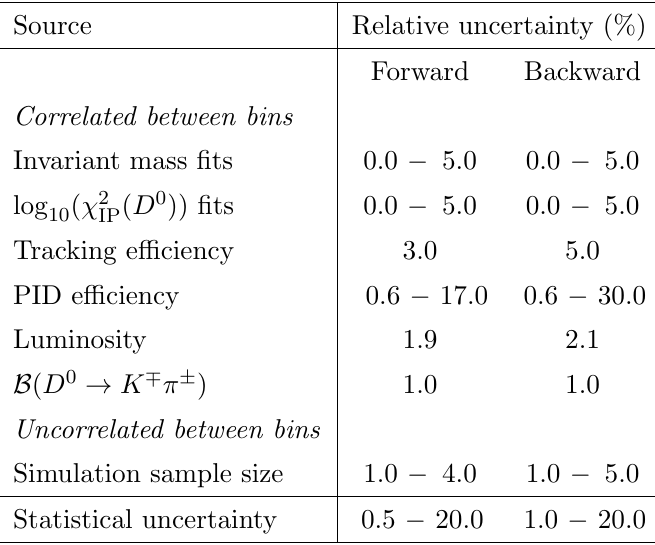
Table 1 . Summary of systematic and statistical uncertainties on the cross-section. The ranges indicate the variations between bins, with the uncertainty on average increasing with rapidity and